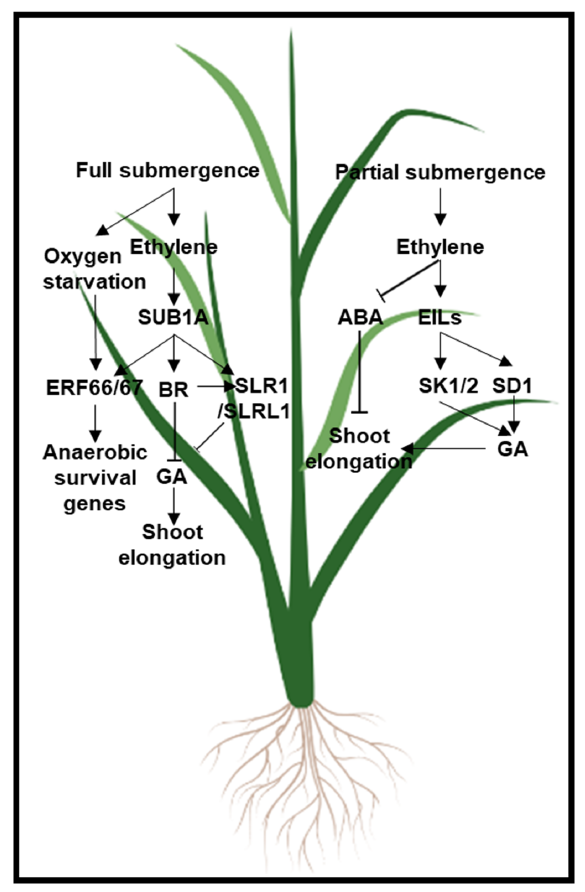
Figure 4. A model of rice adaptation to partial and complete water submergence regulated by GA, ABA, BR, and ethylene. Upon full submergence of rice plants under water (left box), ethylene acti- vates transcription of an ERF TF gene SUB1A , and the SUB1A protein then up-regulates anaerobic survival genes via the transcriptional induction and protein stabilization of ERF66/67 upon hypoxia stress. In addition, ethylene suppresses GA-mediated stem elongation by directly activating the transcription of DELLA protein genes, SLR1 and SLRL1 , as well as by inhibiting BR signaling. Upon partial submergence under water (right box), ethylene acts via the EIL proteins to induce the tran- script levels of ERF genes SK1 and SK2 bringing about the GA signaling-mediated stem elongation in rice. In deepwater wild rice, EIL-mediated signaling triggered by the hormone ethylene directly enhances GA production and induces shoot elongation by transcriptionally activating a GA biosyn- thesis gene SD1 that encodes a GA20-oxidase. Furthermore, ethylene promotes shoot elongation by relieving ABA-imposed shoot growth inhibition. Positive interactions such as activation, produc- tion, and stabilization are represented with lines that end in an arrowhead → . Negative interactions such as inactivation and repression are represented by lines that end in a hammerhead ⊣ . The back- ground image of a rice plant was created with BioRender. Another interesting example that illustrates the synergistic regulatory effects of eth- ylene and BR is the process of stomatal closure. In Arabidopsis, BR induces stomatal clo- sure by triggering H 2 O 2 and NO production [110], Figure 3. BR-stimulated H 2 O 2 and NO accumulation is significantly decreased in the dominant ethylene-insensitive mutant etr1 but is strengthened in the ethylene overproducing ACS5 mutant ethylene overproducer1-1 [110], suggesting that BR-mediated stomatal closure is dependent on ethylene signaling.